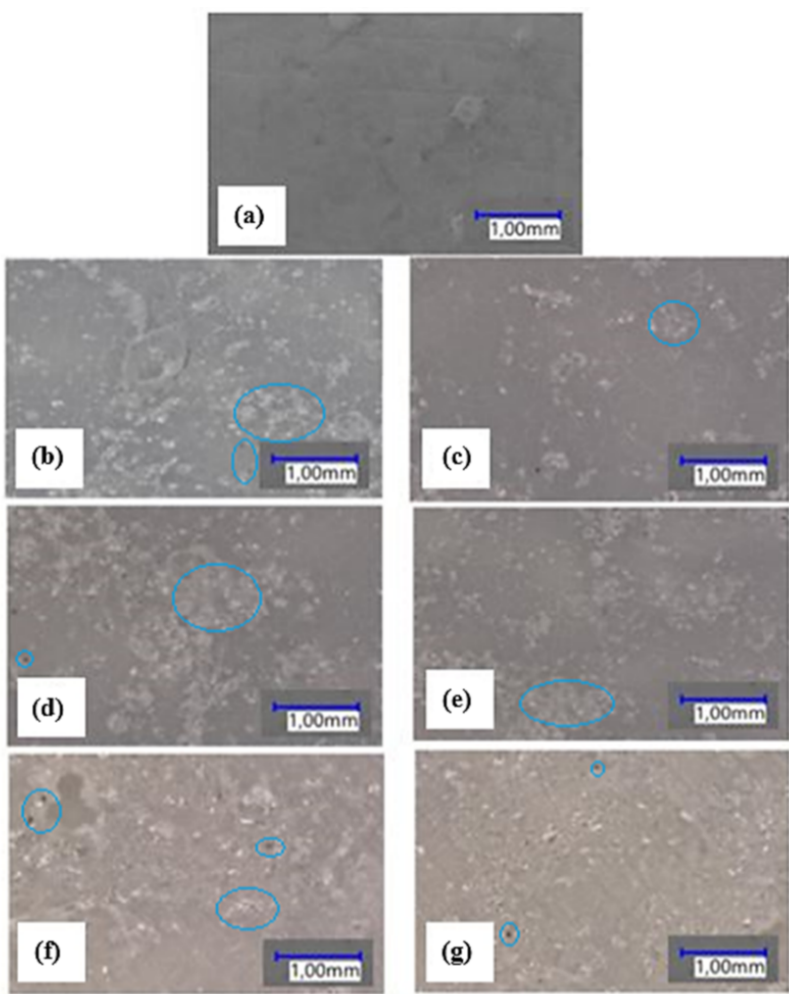
Figure 15. Micrographs of linear low-density polyethylene and composite samples: ( a ) pure LLDPE, ( b ) LLDPE/5%QF, ( c ) LLDPE/15%QF, ( d ) LLDPE/35%QF, ( e ) LLDPE/5%QF/HDPE-g-MA, ( f ) LLDPE/ 15% QF/HDPE-g-MA, ( g ) LLDPE/35%QF/HDPE-g-MA (examples of agglomerates and pores are marked in